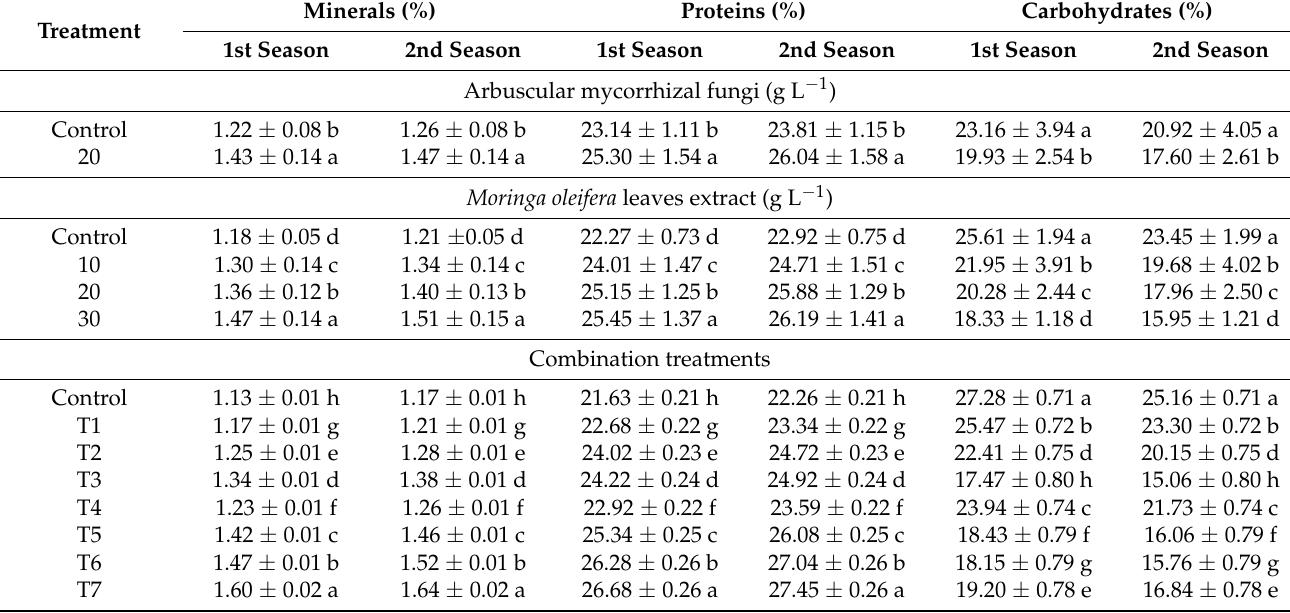
Data are mean value ± SE. Means in columns followed by the same letter are not statistically different at the 0.05 significance